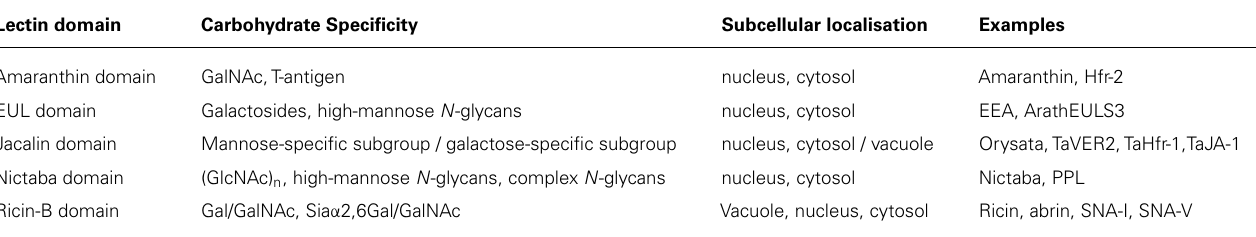
Table 3 | Nucleocytoplasmic lectin domains involved in plant defense signaling. Lectin